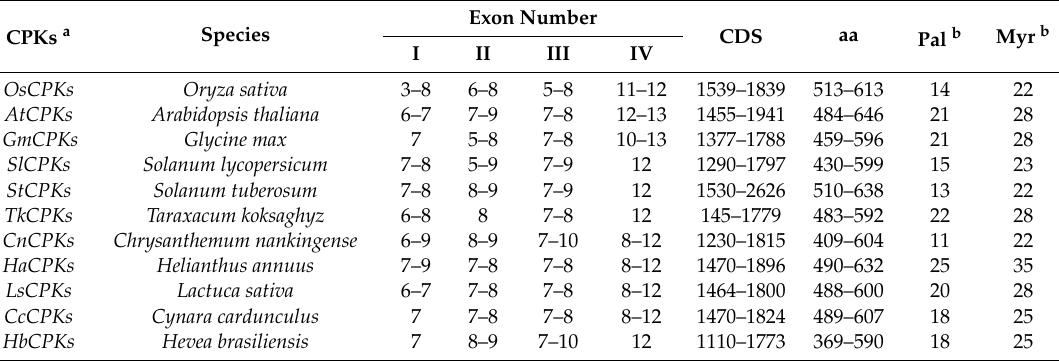
Table 1. Detailed information of calcium-dependent protein kinases (CPKs) in this study. CPKs